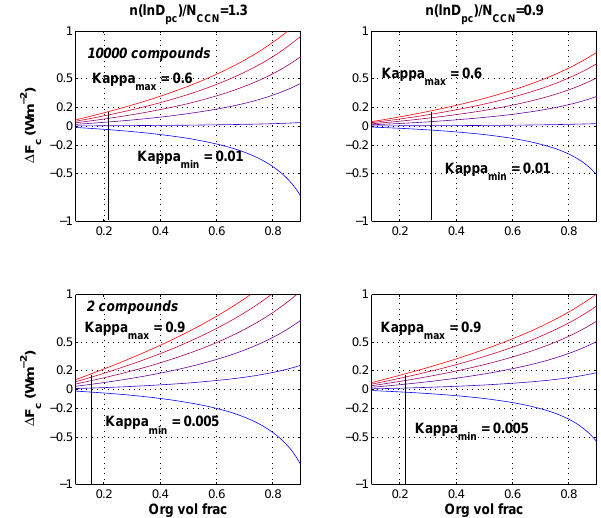
Fig. 5. Uncertainty in the first indirect effect 1F as a function of κ org and x org (organic volume fraction). The range of κ org were derived from simulations assuming no re-equilibration of all semi- volatile components to the dry state using two different methods to calculate p 0 . The maximum κ org is represented by the top red line, the minimum κ org represented by the blue line. Each column repre- sents two different size distributions, the top plots 10000 compound simulations, the bottom plots 2 compound simulations.